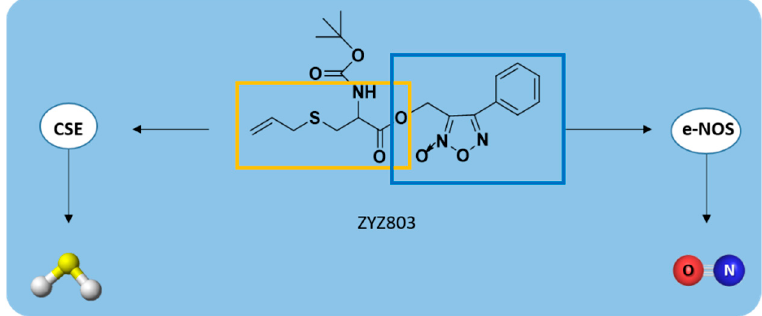
Figure 17. H 2 S/NO-releasing mechanism from ZYZ803. As reported by Hu et al., ZYZ803 significantly promoted endothelial cell angiogenesis both in vitro and in vivo [185].